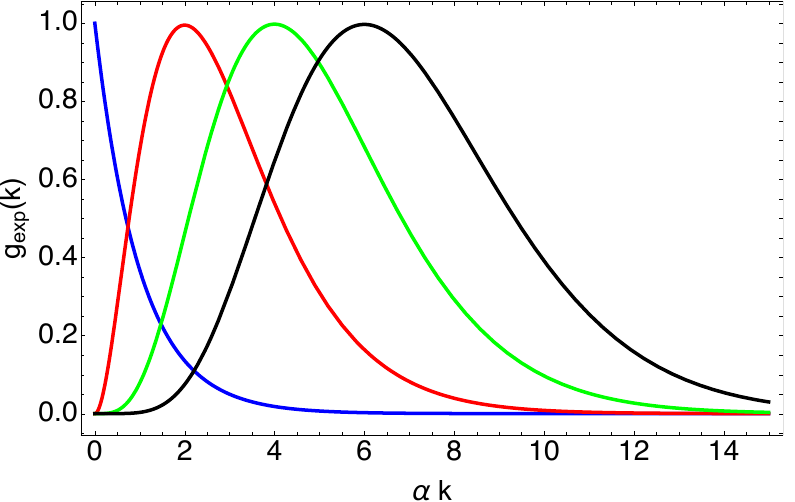
Figure 1. Exponentially decaying spectrum of fundamental X-waves, as given by Equation (5), for different values of the parameter n , namely n = 0 (blue), n = 2 (red), n = 4 (green), and n = 6 (black). As can be seen, as n grows, the spectrum shifts its maximum towards higher frequencies. For this plot, k is measured in units of α